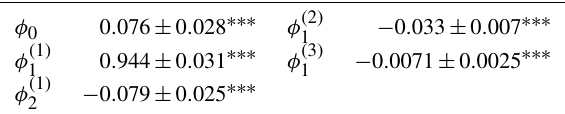
Table 2. Parameter estimates for an SDNAR model for the daily winter NAO